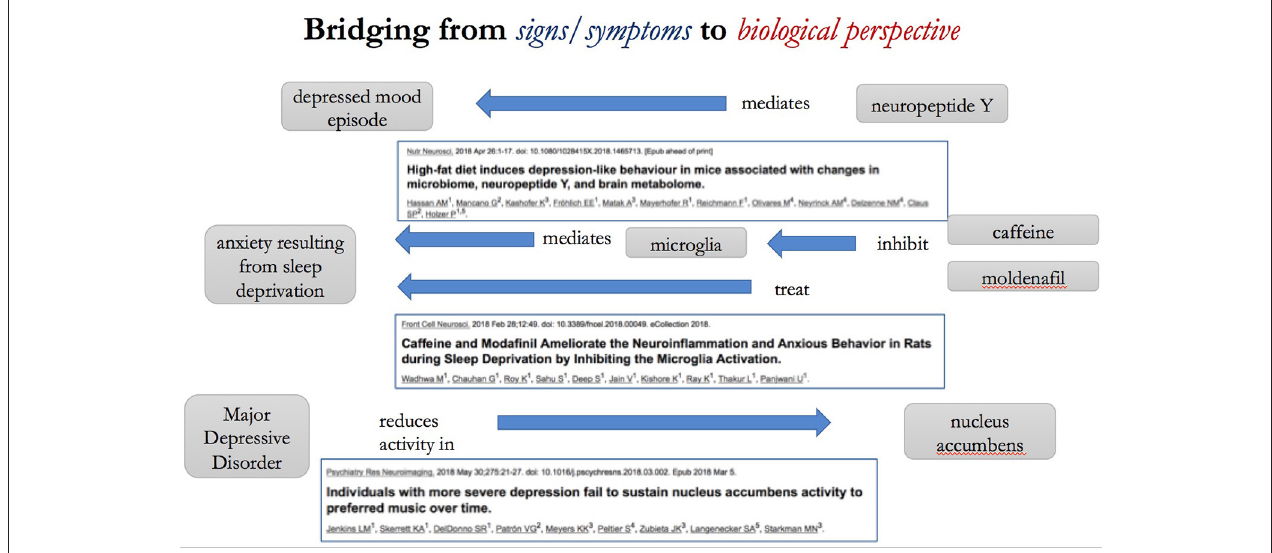
FIGURE 6 | Bridging from the sign/symptom perspective to the biological perspective. The Figure illustrates potential “bridging” annotations taken from recent scientific articles [( 51–53)].